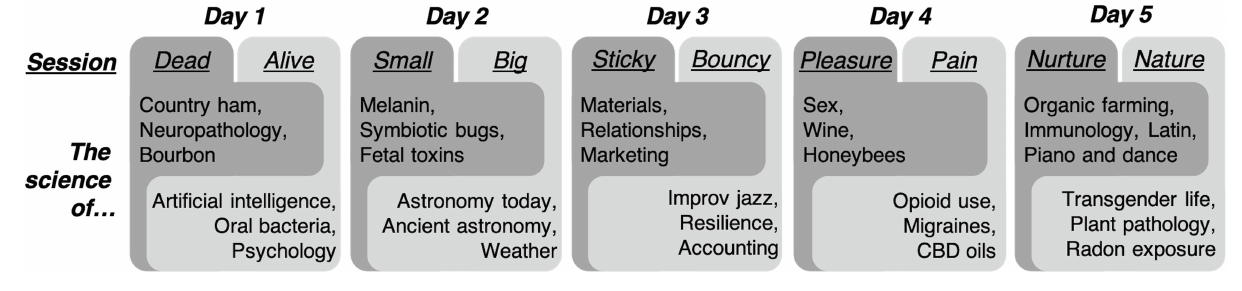
FIGURE 1 | Overview of Programming in Year Two of EiS festival. A total of 33 presenters over 5 days at two events per night provided presentations to the community related to the topics shown. Each topic aligned with the broadly defined